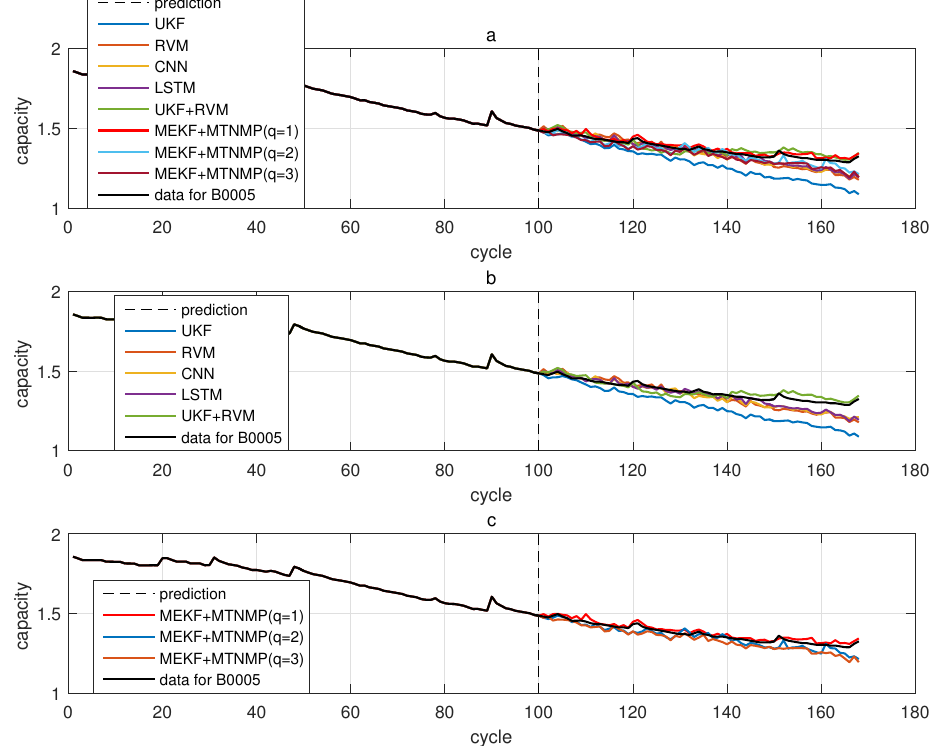
Figure 6. The simulation diagram of B0005 predicted from the 100th time. ( a ) is the experimental diagram of all methods, ( b ) is other methods used for comparison in ( a , c ) is the method proposed in this paper in ( a